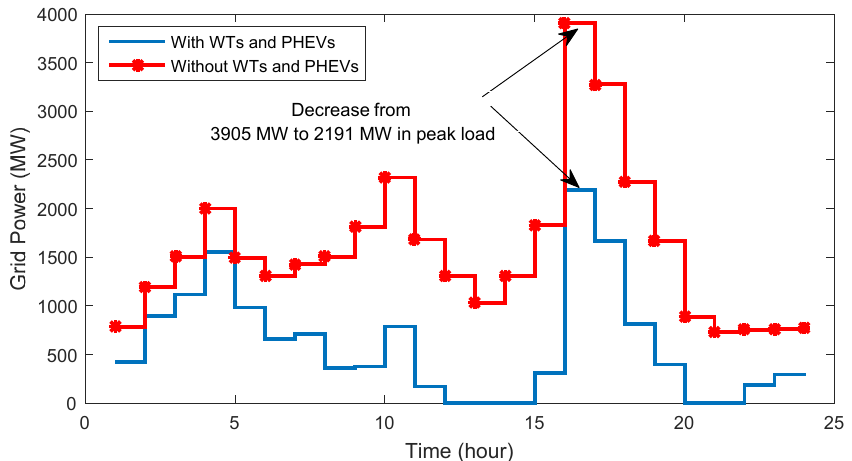
Figure 12. Purchased power from the main grid with and without OSPF via the AOA for 24 h.